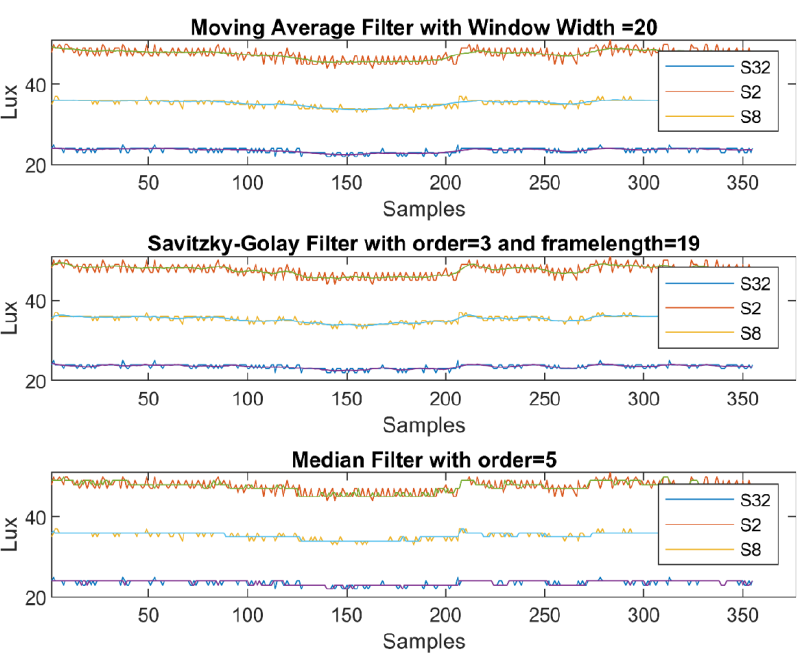
Figure 9. The smoothing action of the filters for selected S2, S8, and S32 sensors. For three filtering methods, all 37 light sensors data were plotted to show light sensors value when the light source was spotted directly to the location of S1 at an elevation of 0 degree (Figure 10).